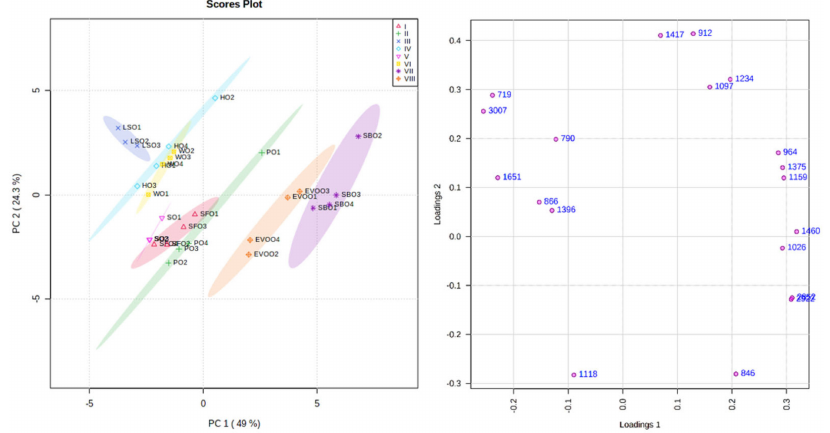
Figure 5. Graphics of PCA analysis: scores ( left ) and loadings ( right ) plots for the 8 groups of oils (I to VIII). For the group individual a ffi liation and abbreviations see Table 1.